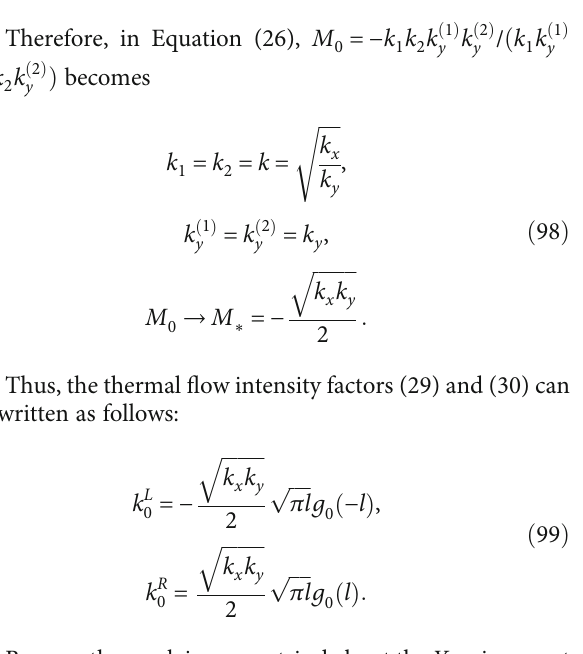
ffiffiffiffiffi π l